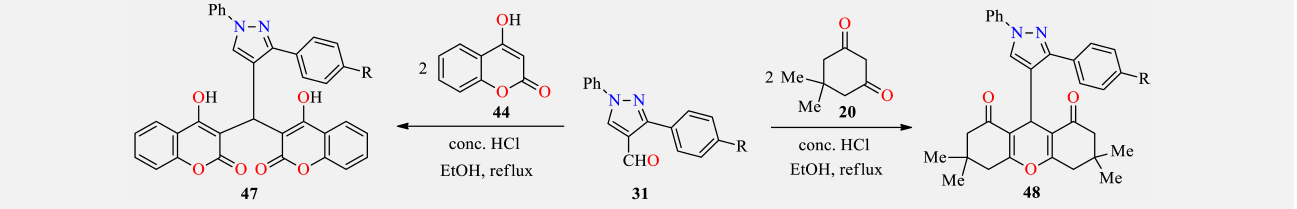
Table 12. Pseudo three-component synthesis and antibacterial evaluation of pyrazolylbiscoumarins 47 and pyrazolylxanthenediones 48